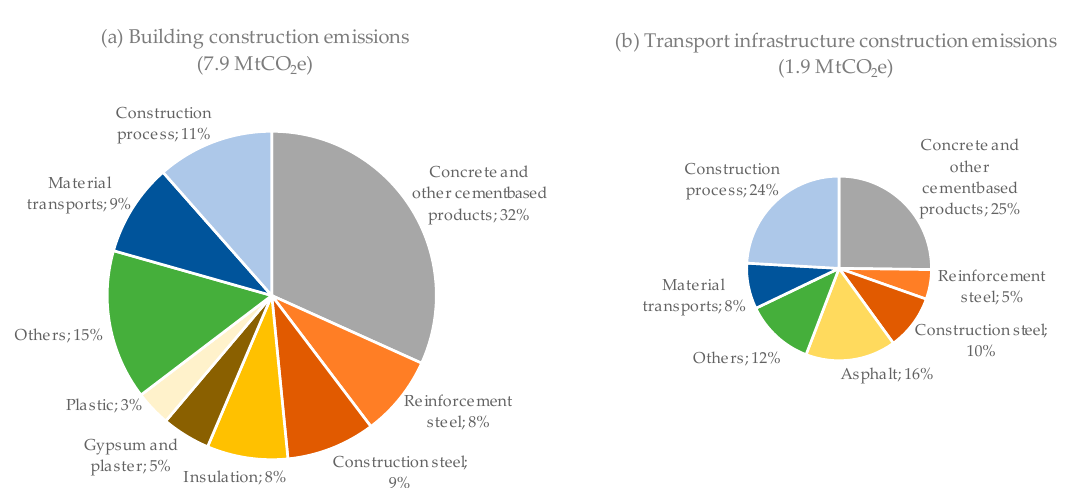
Figure 6. Carbon impact from ( a ) construction of buildings and ( b ) construction of transport infrastructure with the size of the pie charts reflecting the relative magnitude of emissions.